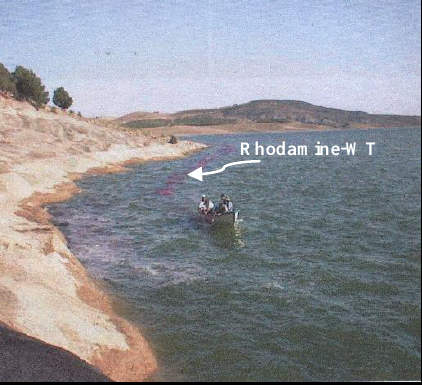
Figure 12. Tracing with Rhodamine – WT at the lake of Hammam Grouz dam